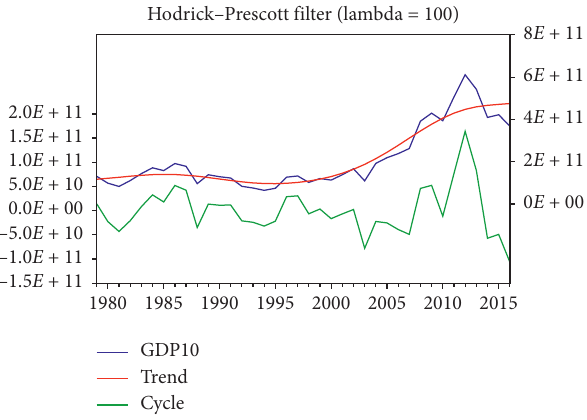
Figure 3: Hodrick–Prescott filter output for a research scenario. Table 6: Results of autoregression estimation scenario 2 research.